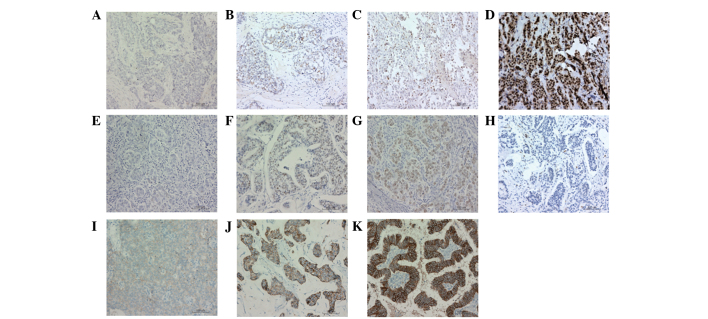
Expression of ERβ, ERα and Her-2 in breast cancer tissue. Expression of ERβ, ERα and Her-2 was determined by immunohistochemistry. Representative images were shown. Cells with brown staining were positive cells and cells with blue staining were negative cells. Magnification, ×400. (A–D) Stained with ERβ antibody. (E–G) Stained with ERα antibody. (H–K) Stained with HER2 antibody.